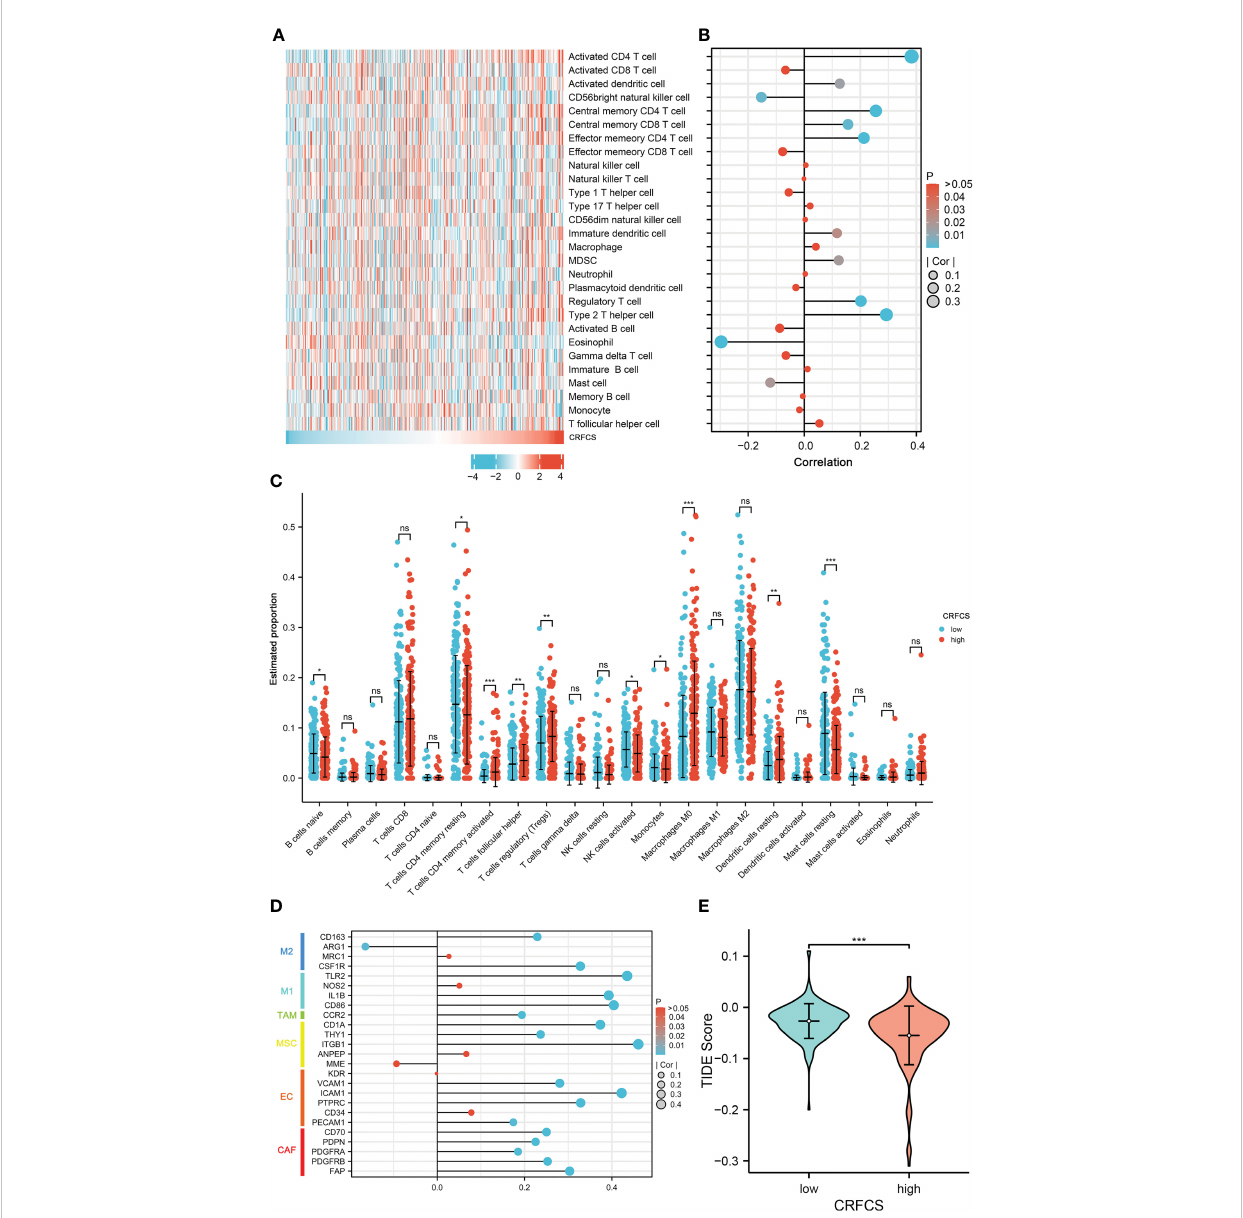
FIGURE 5 CRFCS and immune in fi ltration. (A) Heat map of ssGSEA score of various immune cells in high and low CRFCS groups via analyzing TCGA-LIHC cohort data. (B) The correlations between immune score and CRFCS. (C) Immune in fi ltration landscape of TCGA-LIHC cohort samples assessed by the CIBERSORT algorithm. (D) Correlation of stromal cell-associated markers with CRFCS. (E) The level of immune escape between high and low CRFCS subgroups was assessed by the TIDE algorithm. (*p<0.05; **p<0.01; ***p<0.001; ns stands for not signi fi